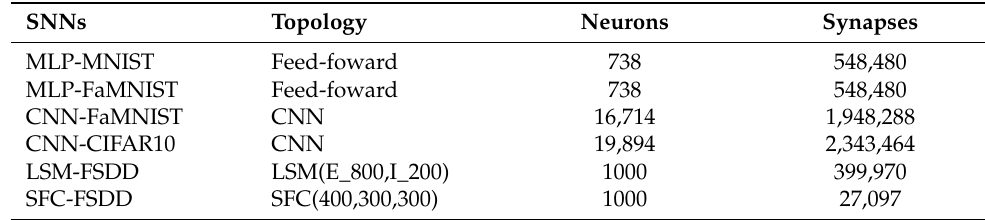
Table 2. SNN-based applications used for evaluation.